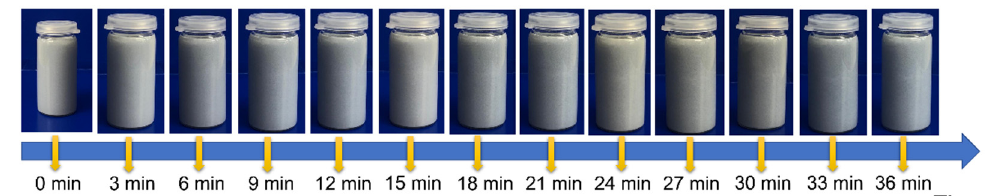
Figure 2. Sample SEM pictures of Al 2 O 3 ( a ) and Ti ( b ) powder.